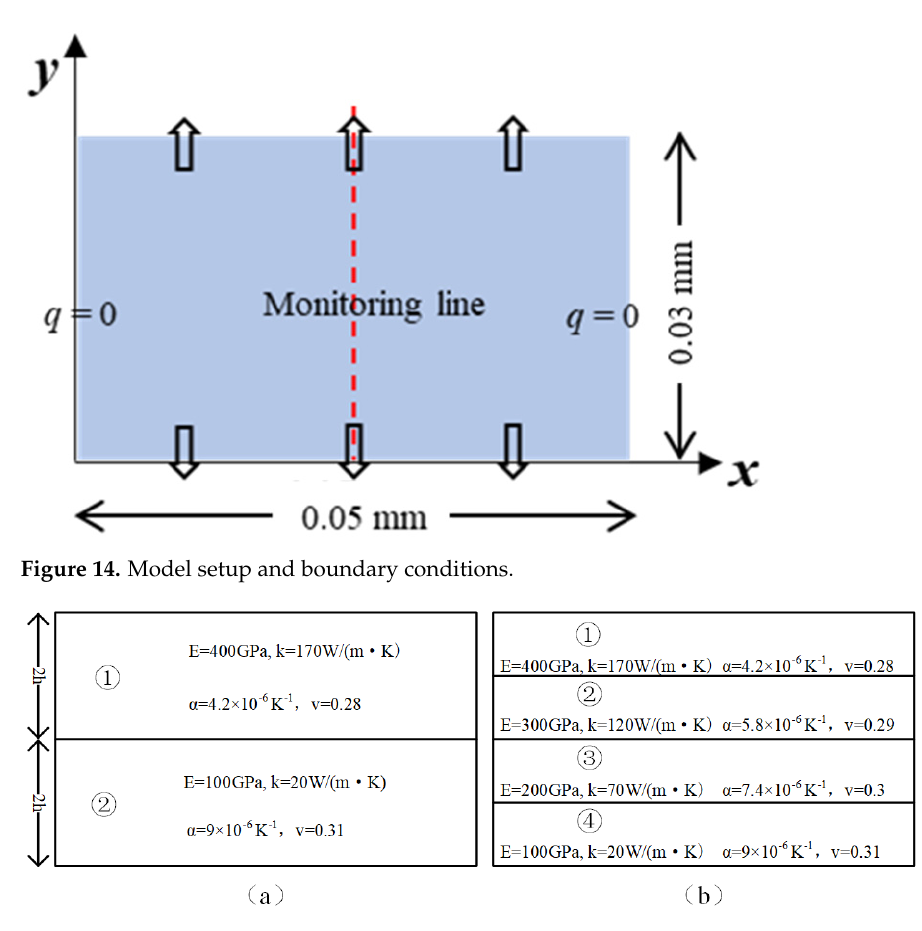
Figure 15. Composite material parameters distribution. ( a ) double-layer material; ( b ) Four-layer material ( h is 1/4 of the model’s width).